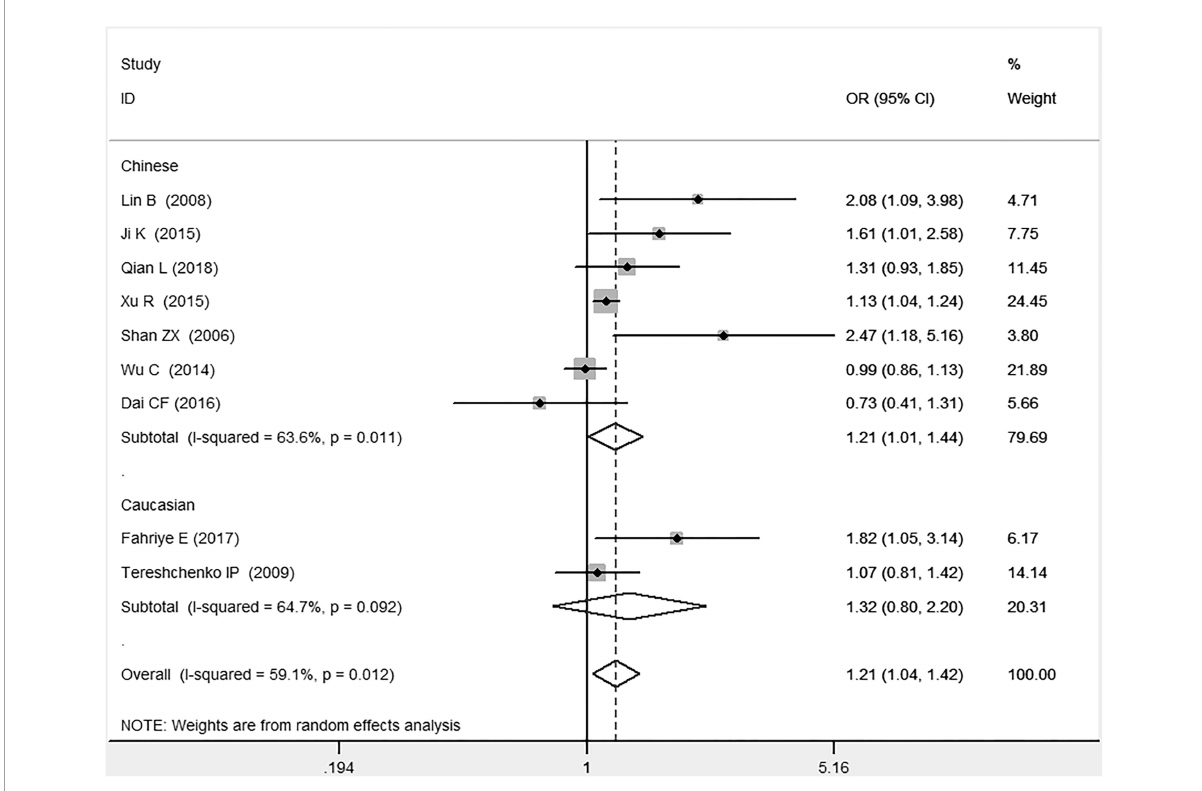
FIGURE1 Forest plot of CAD associated with MIF gene rs755622 G/C polymorphism under an allelic genetic model (i.e., C allele vs. G allele + C allele of MIF gene rs755622 G/C